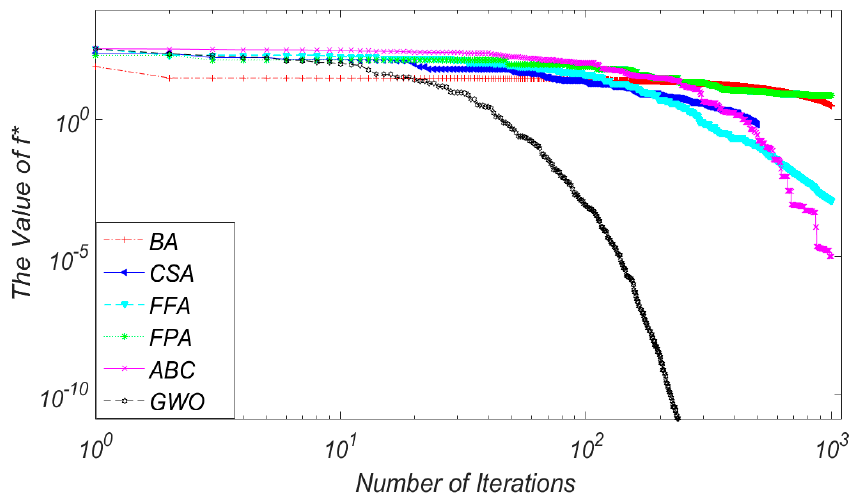
Figure 2. Convergence speed for Sphere ( f 1 ) function (50D).